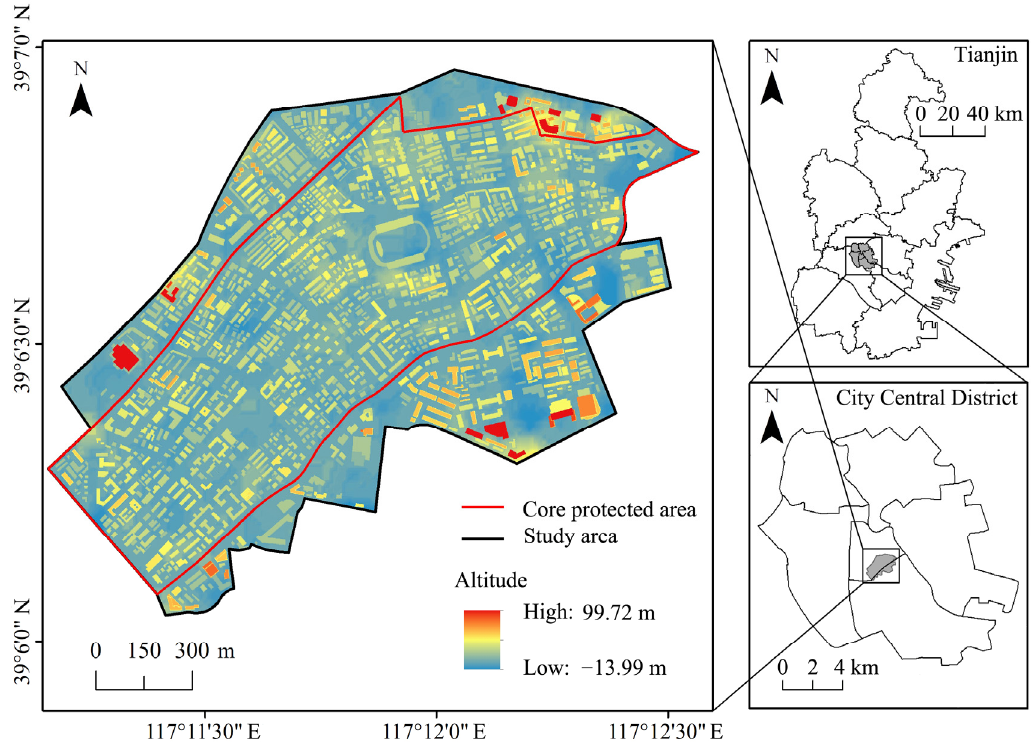
Figure 1. Case study area and geographic location of the Tianjin central district (Altitude refers to the heights of the buildings in relation to the ground level).